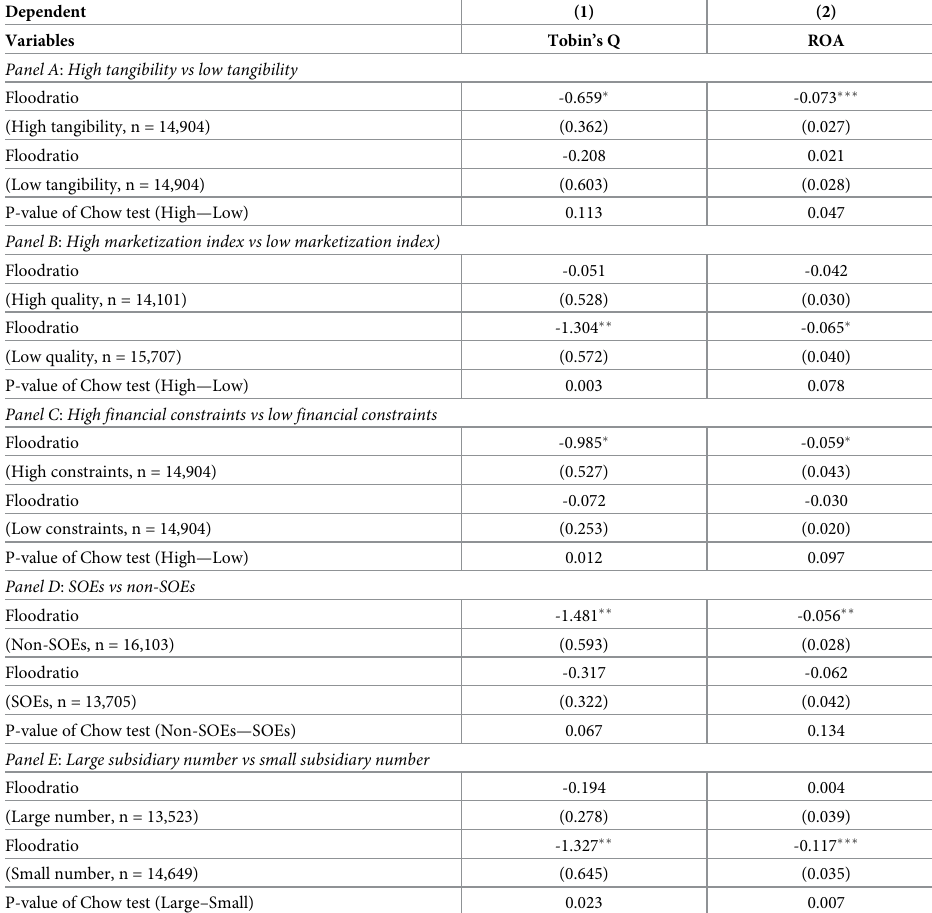
Table 5. Cross-sectional analysis using subsamples. This table reports the subsample regression results of the effects of flooding on firm performance. The sample firms are sorted by capital expenditure (above vs below the sample median CAPEX in each year) in Panel A, by marketization index (above vs below the sample median marketization index) in Panel B, by financial constraints (above vs below the sample median SA index in each year) in Panel C, by state ownership status (non-SOEs vs SOEs) in Panel D, and by operation dispersion (above vs below the sample median number of operating cities in each year) in Panel E, respectively. Control variables, firm fixed effects and year fixed effects are included in all subsample regressions. Chow tests are conducted to formally test the Floodratio coefficient differences between subsamples. Variable definitions are in Table A1 in the S1 Appendix. Robust standard errors are clustered at the city-year level and reported in parentheses. � , �� and ��� indicate the significance levels at 10%, 5% and 1%,